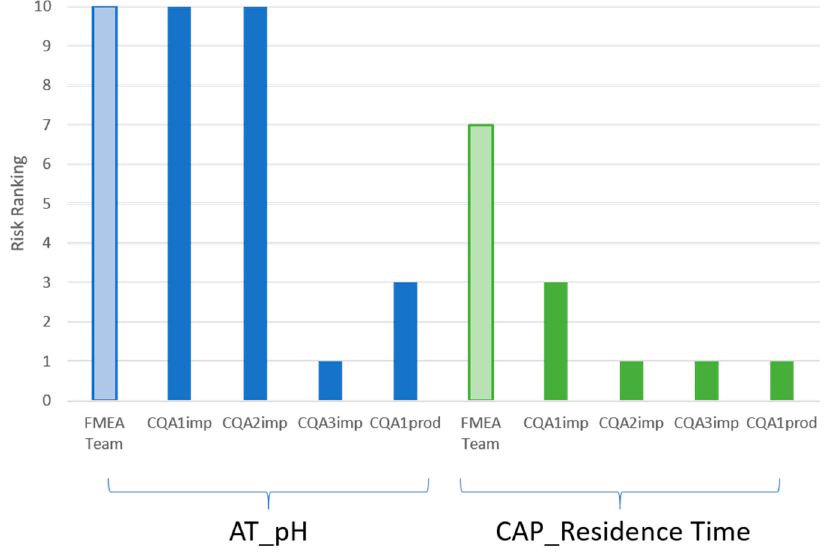
Figure 4. Results of the algorithmic setting of the FMEA severity ranking per CQA. The FMEA team bar represents the current process-expertise-based ranking with the granularity of final ranking for the worst-case CQAs. The IPM ranking assesses each of the CQAs against the 2 parameters in question. As CPPs are classified as ranking 10, AT_pH will be considered a CPP in both assessments, whereas CAP_Residence Time will be considered a PP. While both methods agree with the final ranking, there is a difference in the assessment of CAP_Residence Time, with the FMEA team ranking this as a more critical parameter than the PSA.